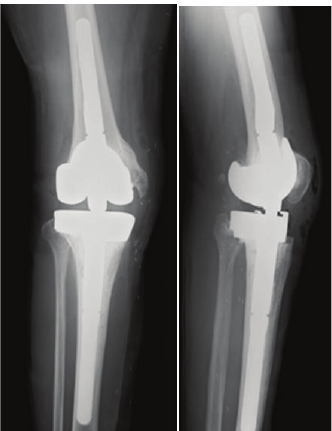
Figure 2: Postoperative anteroposterior radiograph of right knee.